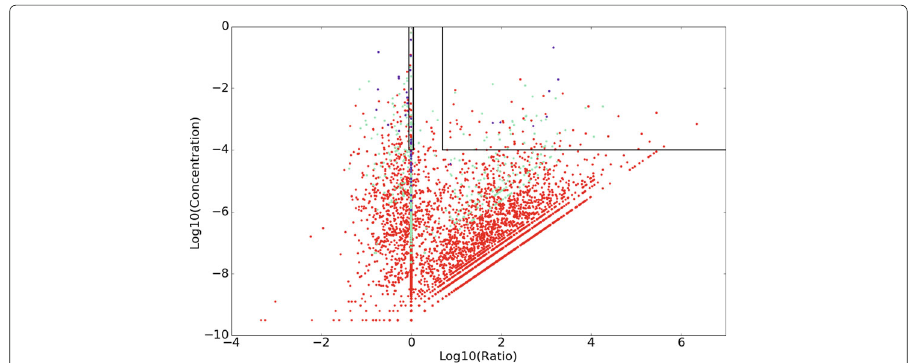
Fig. 6 Ratio (horizontal axis) vs concentration (vertical axis) for all patterns. Top right box indicates cut-off values. Patterns of size 3 in blue, size 4 in green and size 5 in